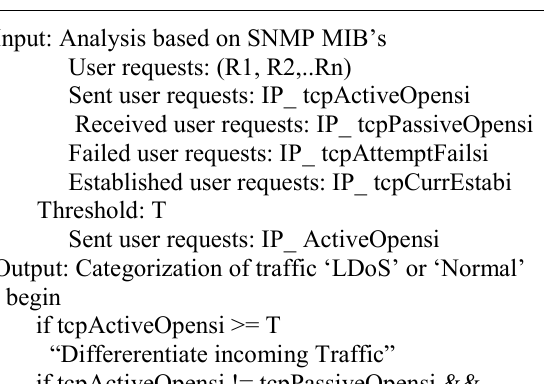
Algorithm 1:Attack